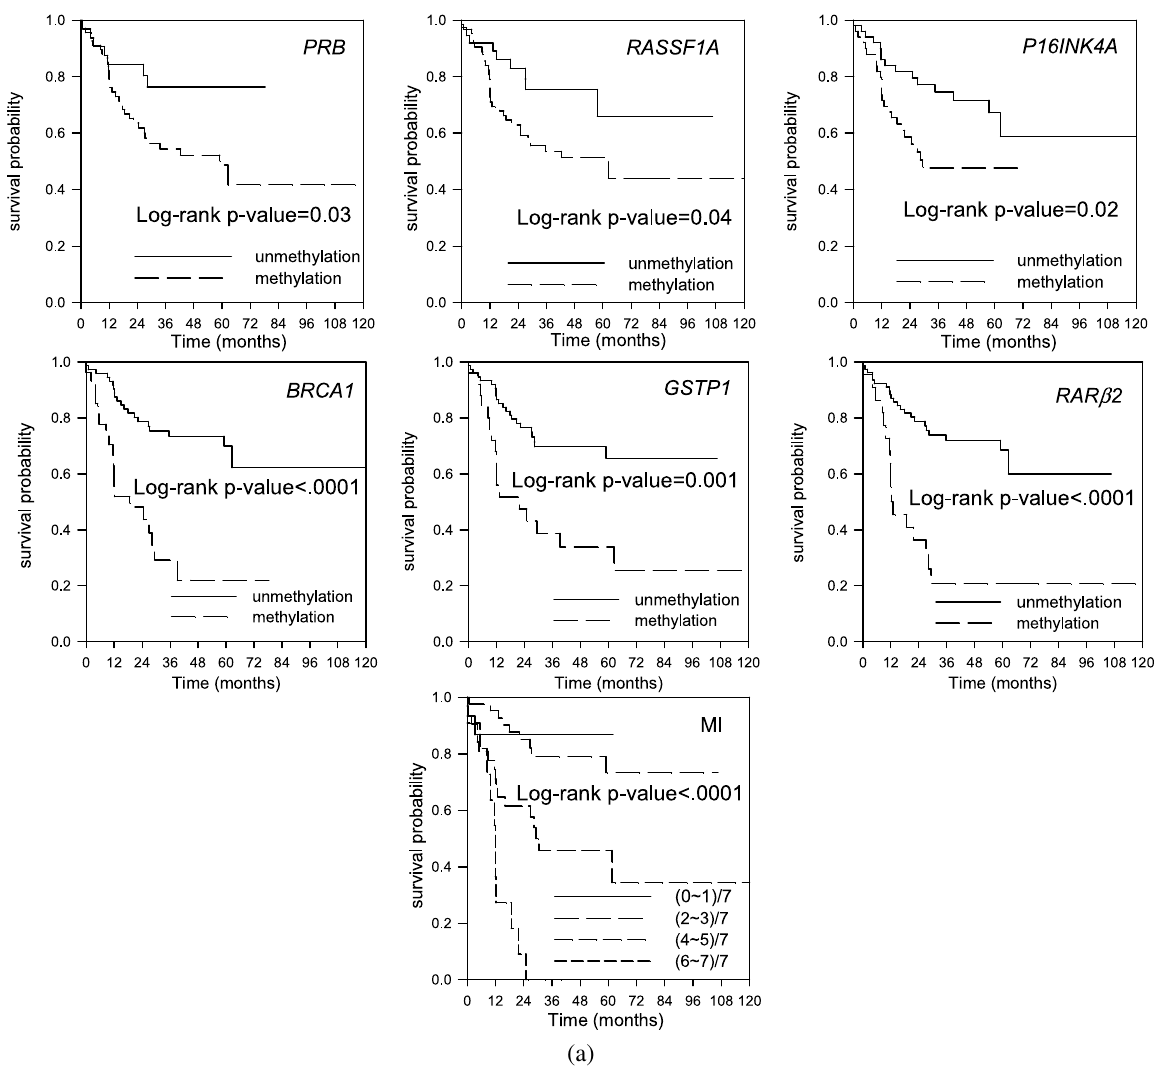
Fig. 2. Kaplan–Meier survival curves to demonstrate a relationship between each gene methylation and methylation index (MI) with the proba- bility of disease free survival (a) and overall survival (b) among all the breast cancer patients. methylation of p16INK4A , BRCA1 , ER α and PRB